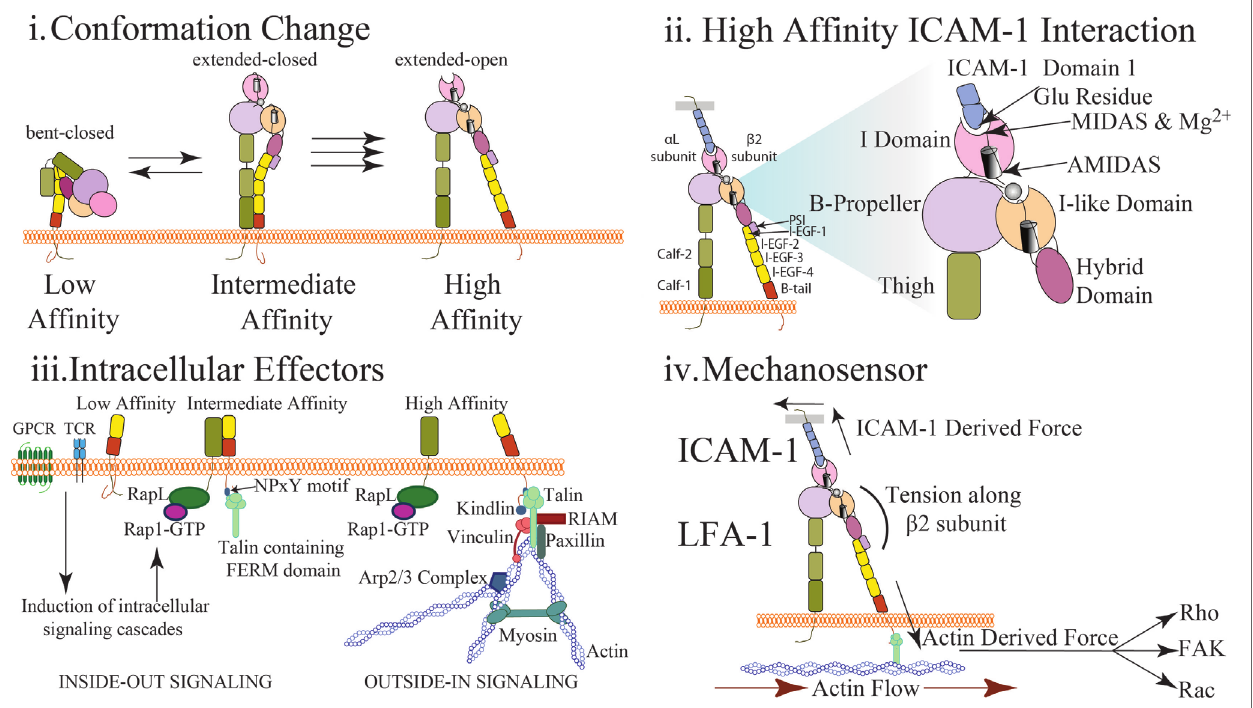
FigURe 1 | Multidimensional regulation of LFA-1 affinity (i) LFA-1 affinity regulation is mediated via conformational changes to LFA-1 structure. In the low affinity state, the bent conformation causes the ligand binding α I domain to be inaccessible to interact with ICAM-1. In the intermediate affinity state, the extracellular leg domains are straightened allowing for low affinity interactions between LFA-1 and ICAM-1. Importantly, the intracellular domains of LFA-1 are not separated and the metal ion-dependent adhesion site (MIDAS) binding site closed. In the high affinity state, disruption of the salt bridge between the α and β cytosolic tails results in conformational shift along the β subunit and α I domain resulting in high affinity LFA-1 via the opening of the ligand-binding site. (ii) The α I domain contains the MIDAS within which resides Mg 2 + coordinating the binding pocket. This site interacts with the glutamic acid-34 in Domain 1 of ICAM-1 to facilitate binding. This induces a shift in the α 7 helix to cause the hybrid domain to swing out further stabilizing LFA-1 structure. Additional sites surrounding the MIDAS such as AMIDAS and ligand-induced metal-binding site assist with coordination of the binding pocket and stabilization of high affinity LFA-1. (iii) Upon T cell receptor or chemokine activation, RAP1-GTP recruits a number of factors including RAPL that interact with the α subunit of LFA-1 to induce integrin activation (inside-out signaling). Similarly, talin cleavage allows the FERM domain to interact with the NPxY motif of the cytosolic tail on the β subunit. This interaction causes a dissociation of the salt bridge inducing cytosolic tail separation. Kindlin also contains a FERM domain and interacts with the β subunit to further stabilize high affinity LFA-1. Molecules such as RIAM, talin, paxillin, and vinculin may interact with the cytosolic tails to recruit additional effector molecules and promote a scaffold to interact with actin and reinforce LFA-1 activity (outside-in signaling). Arp2/3 will promote continued actin filament growth while MyH9 functions to provide stress on actin fibers to induce LFA-1 dissociation from ligand. (iv) Interaction of LFA-1 with ICAM-1 and β -actin allows for force driven responses along the β subunit. Transmission of force (arrows) along the β -subunit has been measured in pN scale with actin flow functioning to direct the orientation and location of LFA-1 both at the immunological synapse and during cell migration. Stabilization of the integrin in the high affinity conformation via force generation requires adhesion to both the cytoskeleton and ICAM-1. The stiffness of the substrate may also alter the level of force generated thus altering the signaling response. Downstream signal is induced via outside in signaling generated through the stabilization of high affinity LFA-1. Phosphorylation of focal adhesion kinase through force generation may play a role in mediating